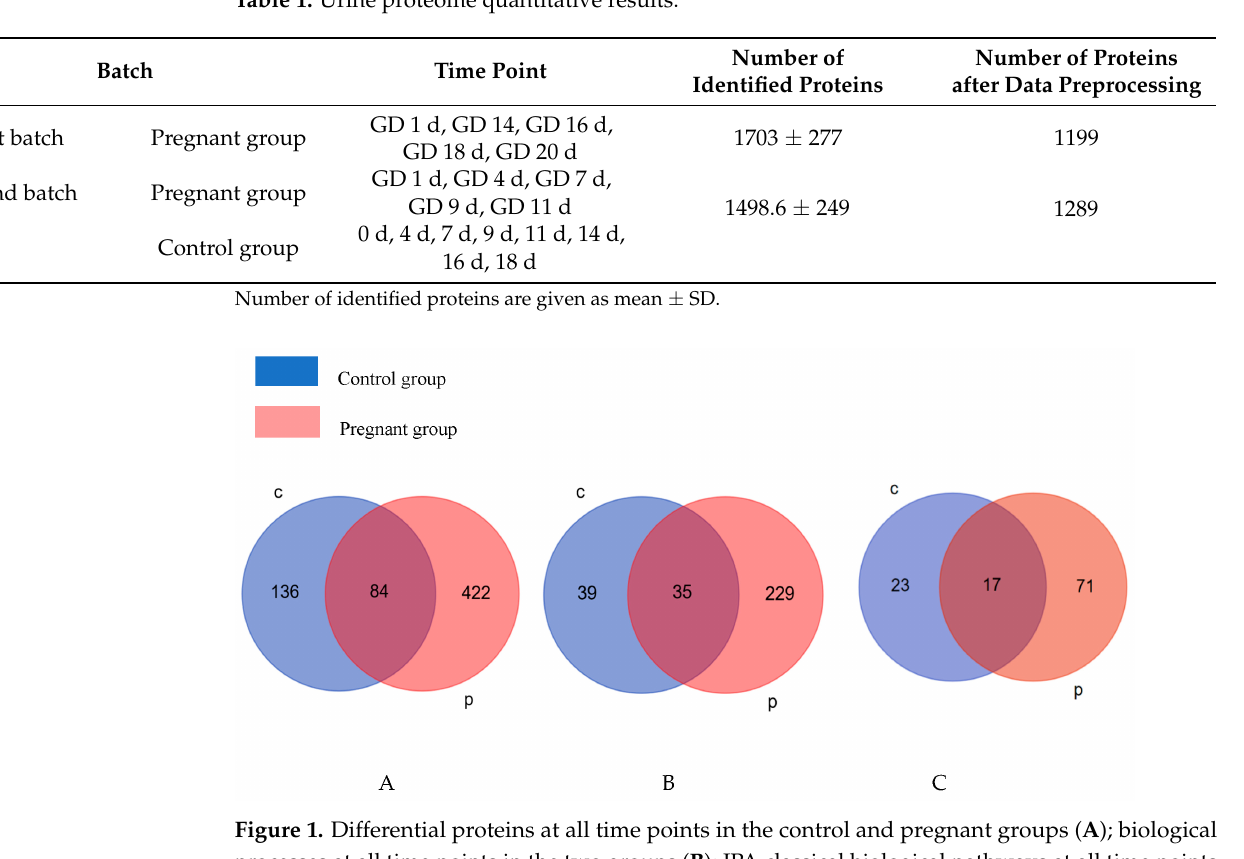
Table 1. Urine proteome quantitative results.